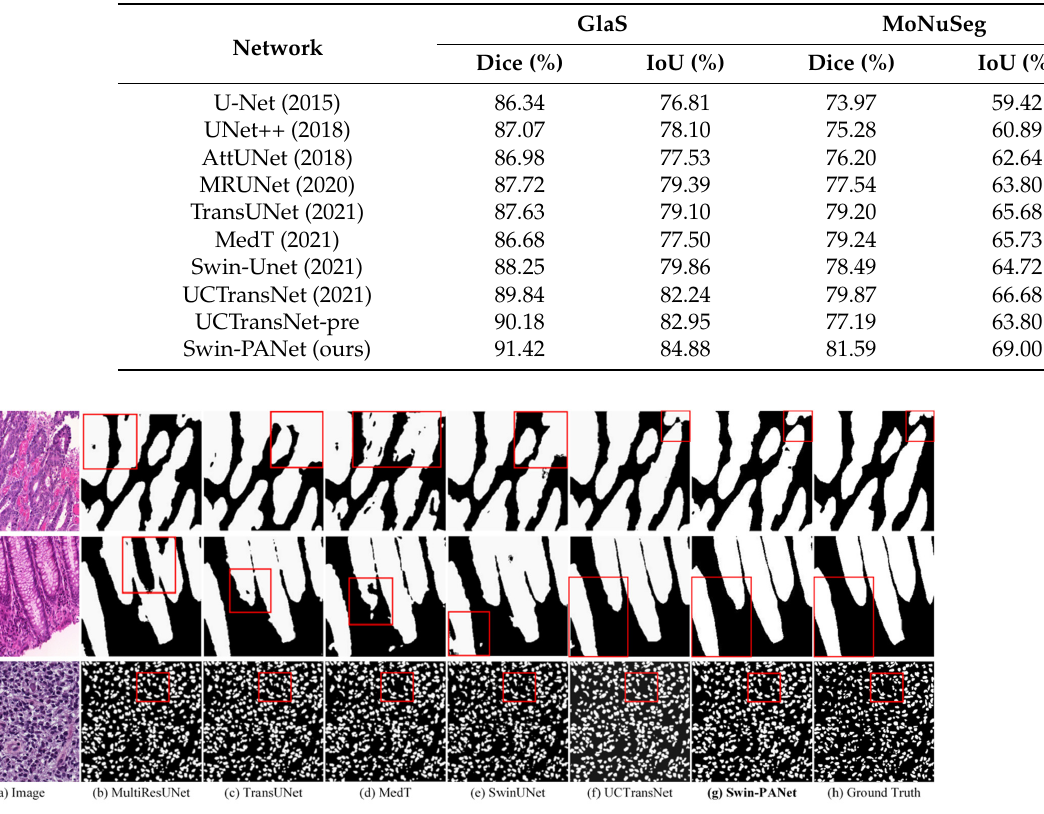
Figure 5. Visual comparisons of nuclear segmentation results produced by different methods on GlaS and MoNuSeg datasets. The first two rows represent segmentation results on GlaS dataset and the last row represents segmentation results on MoNuSeg dataset. The regions highlighted by red boxes show Swin-PANet performs better segmentation than other state-of-the-art methods and the results of segmentation are more similar to the ground truth. Table 1. The quantitative comparison on GlaS and MoNuSeg datasets implemented on state-of-the- art methods. For simplicity, AttUNet and MRUNet denote the above methods: Attention U-Net and MultiReUNet. UCTransNet-pre denotes UCTransNet based on pre-training.